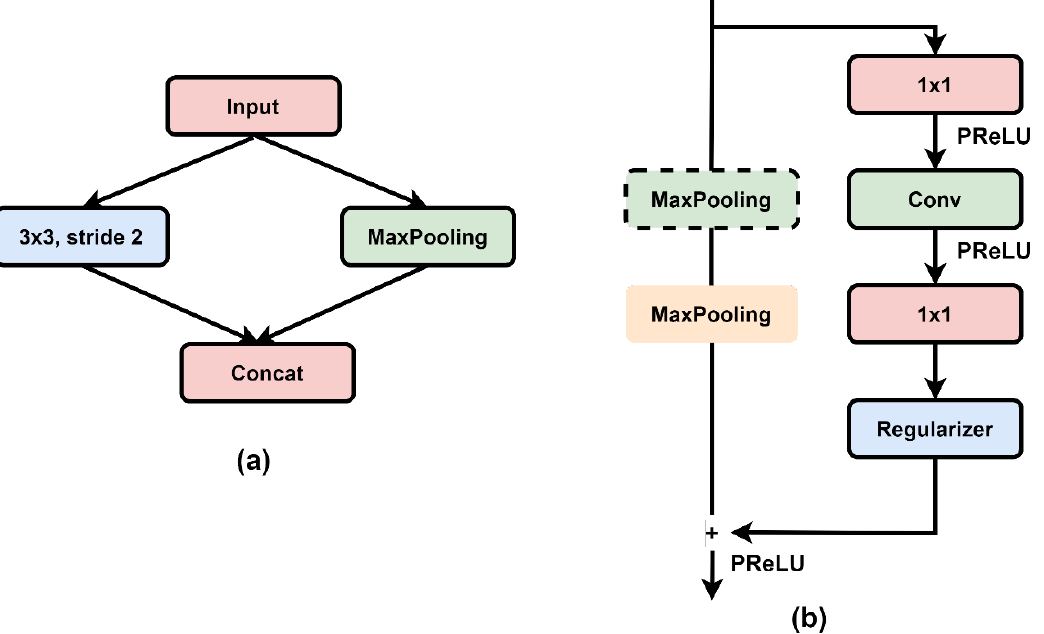
Figure 1. ( a ) ENet initial block; ( b ) ENet bottleneck